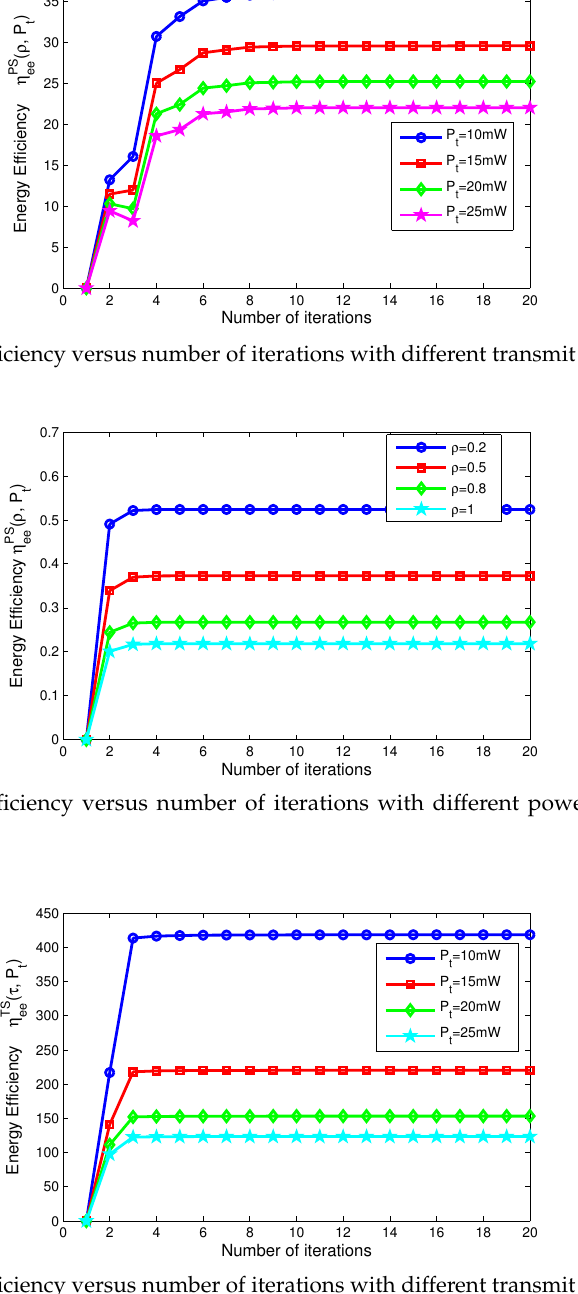
Figure 8. Energy efficiency versus number of iterations with different transmit power for TS